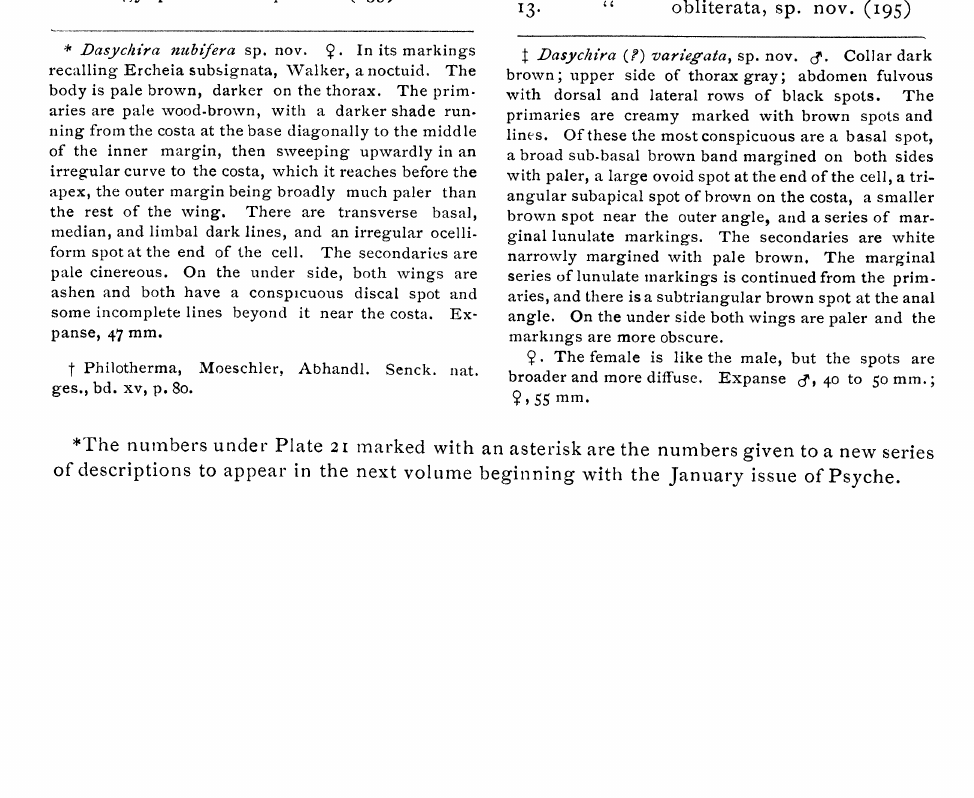
Fig. I. Dasychira apateloides, sp. nov. (98)